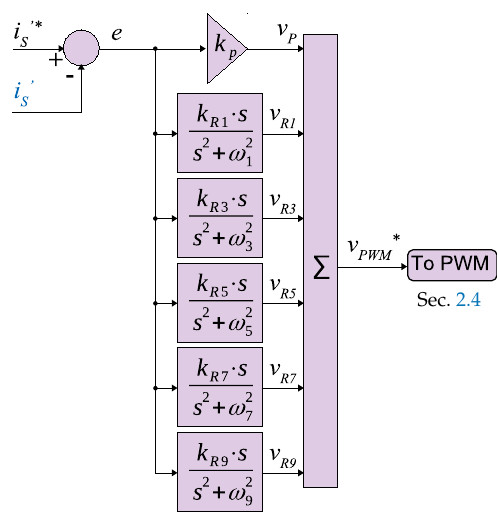
Figure 5. Proportional plus resonant current controller on continuous